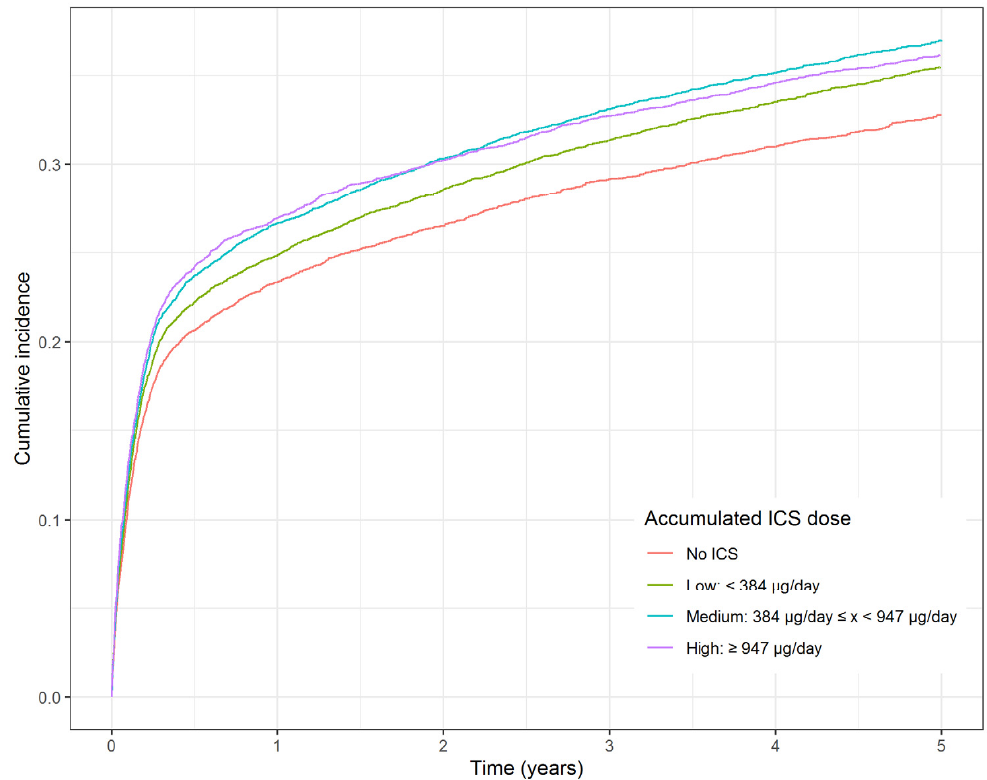
Figure 2. Cumulative incidence function for collection of antidepressants within 5 years using inverse probability of treatment weighing. Abbreviations: ICS: Inhaled corticosteroid. Table 2. Outcomes within 5 years of cohort entry.